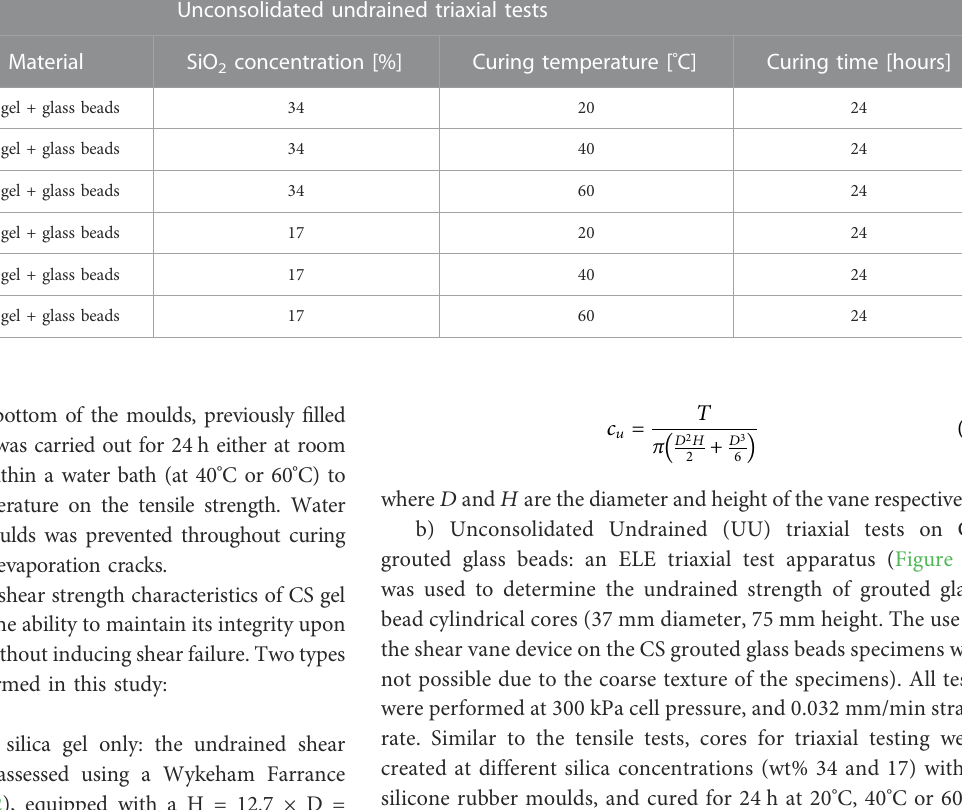
TABLE 3 Summary of Unconsolidated Undrained (UU) triaxial tests for undrained shear strength determination. Unconsolidated undrained triaxial